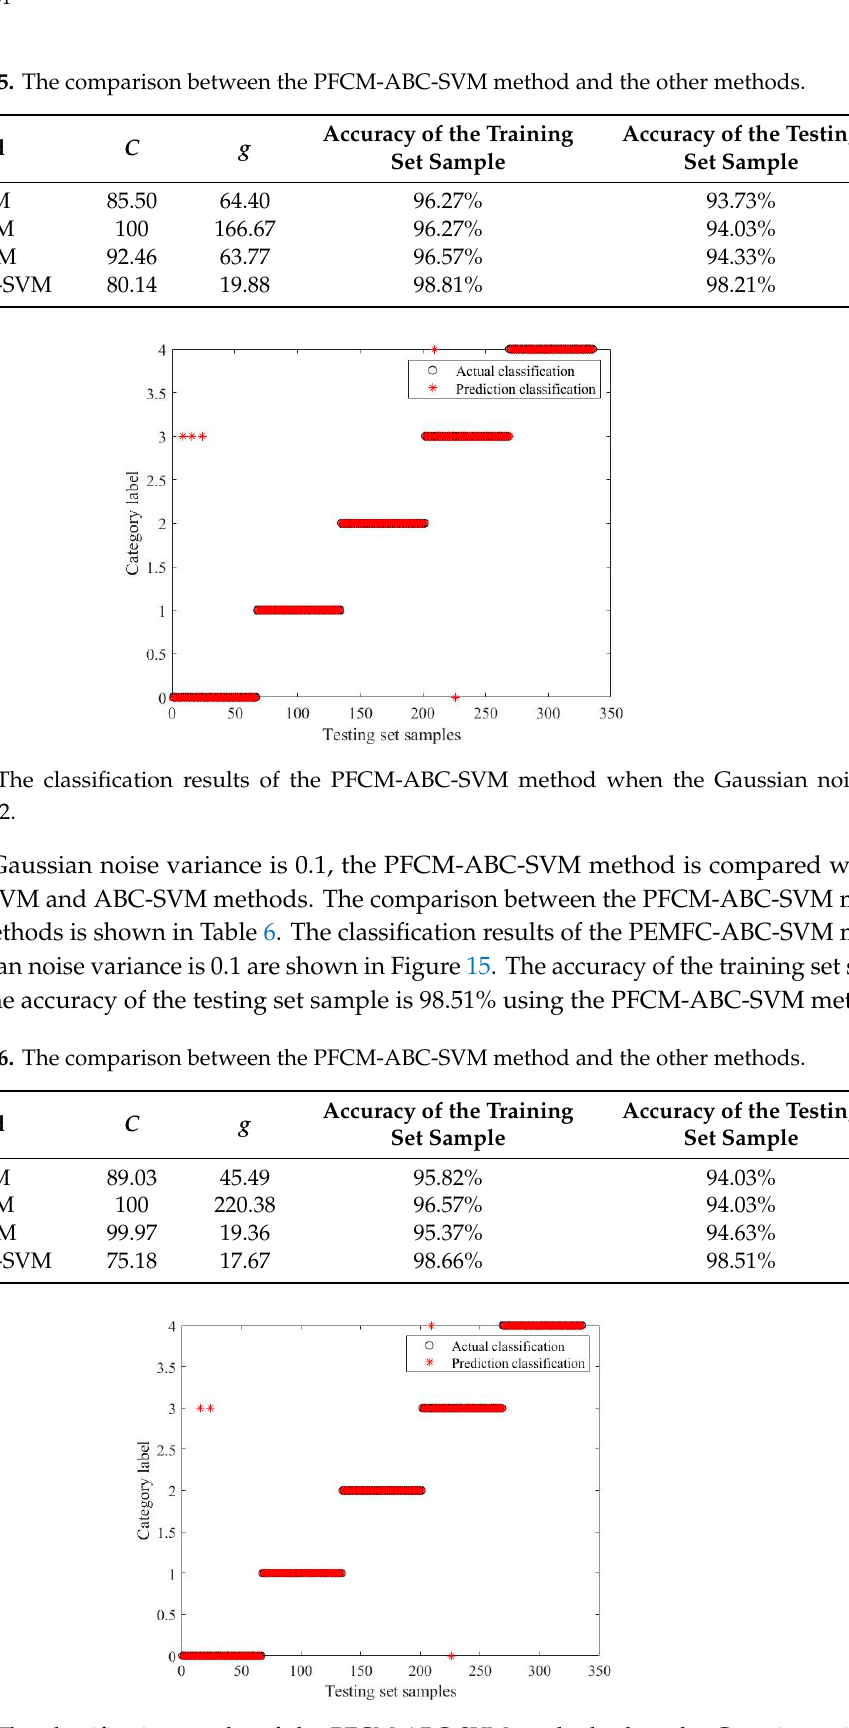
Figure 15. The classification results of the PFCM-ABC-SVM method when the Gaussian noise variance is 0.1.